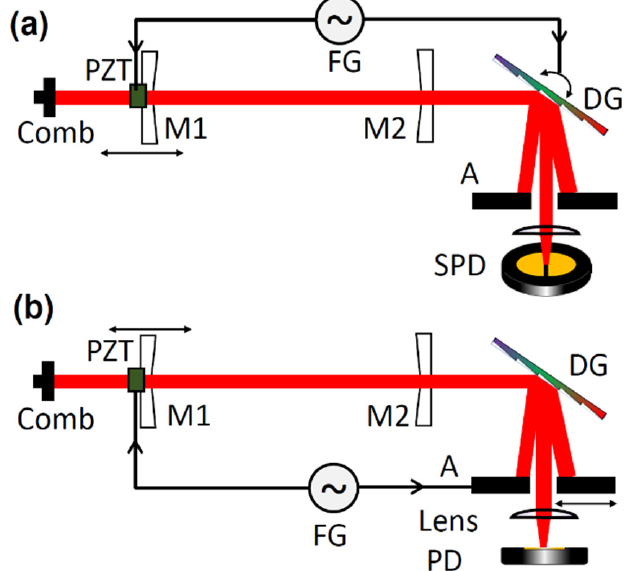
Figure 4. Typical detection schemes of continuous-filtering Vernier spectroscopy: ( a ) spectrometer based on a diffraction grating rotating synchronously with the Vernier order scan; ( b ) spectrometer based on a fixed diffraction grating and a moving aperture synchronized with the Vernier order scan. M1,2: cavity mirrors; PZT: piezo transducer; DG: diffraction grating; FG: frequency generator; A: aperture; SPD, split photodiode; PD: photodiode.